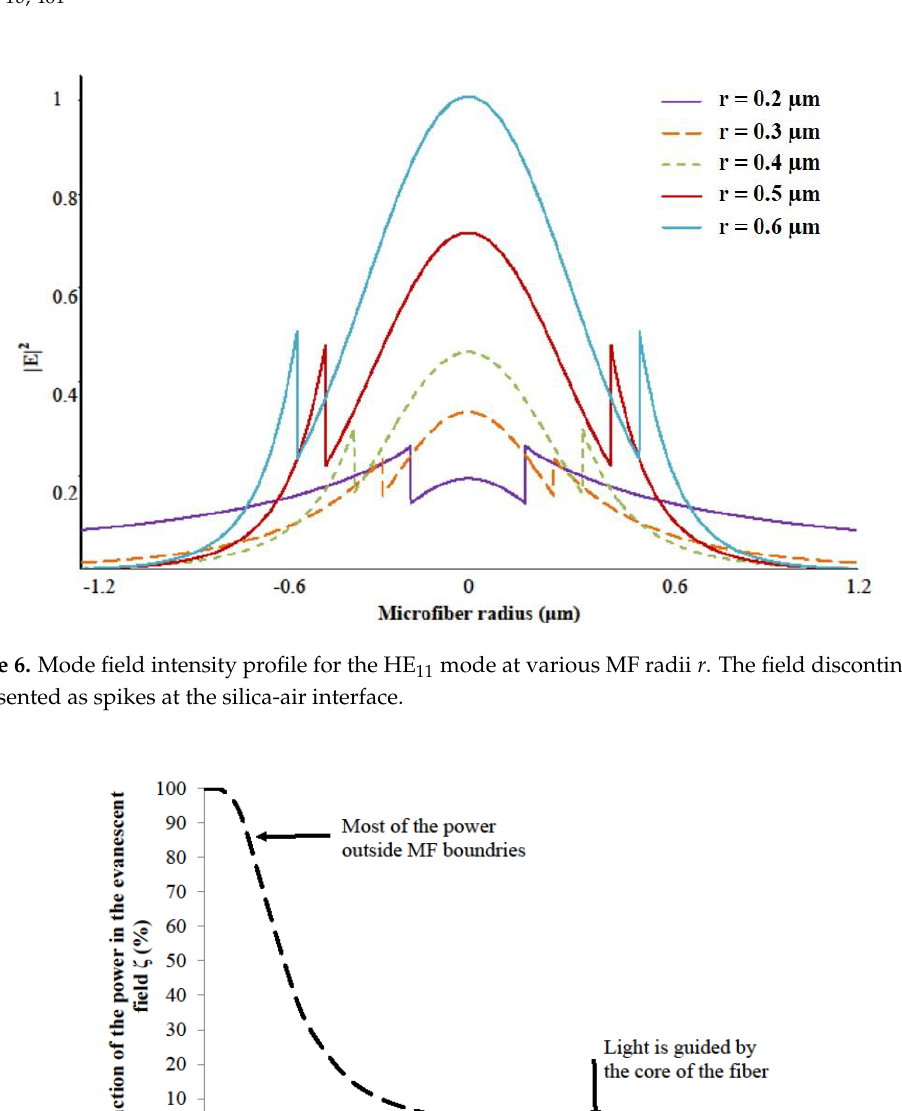
Figure 7. Fraction of the power in the evanescent field against MF radius, for a Silica MF in air at λ = 1.55 μm.